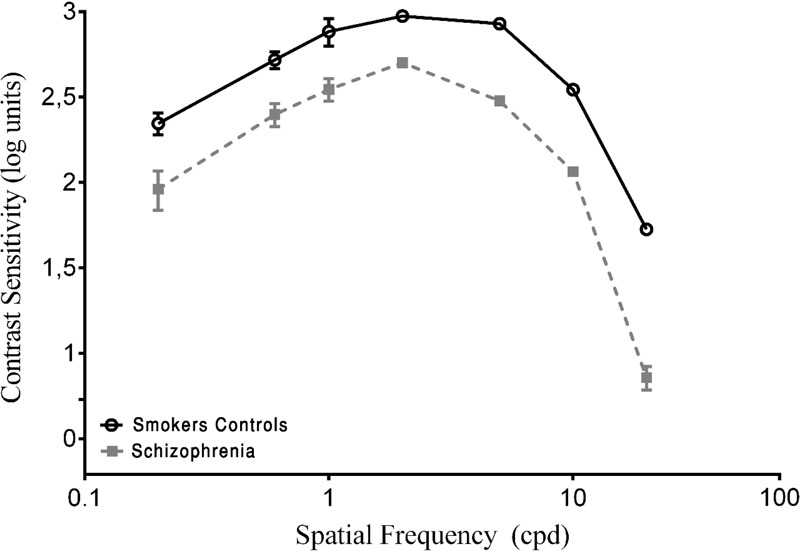
Contrast sensitivity curves as a function of spatial frequency cycles per degree (cpd) in smoker control group and schizophrenia groups. Each data point represents the mean sensitivity (reciprocal of contrast threshold). Error bars represent the standard deviation (SD) of the mean sensitivity. The contrast sensitivity function (CSF) is plotted in logarithmic units.